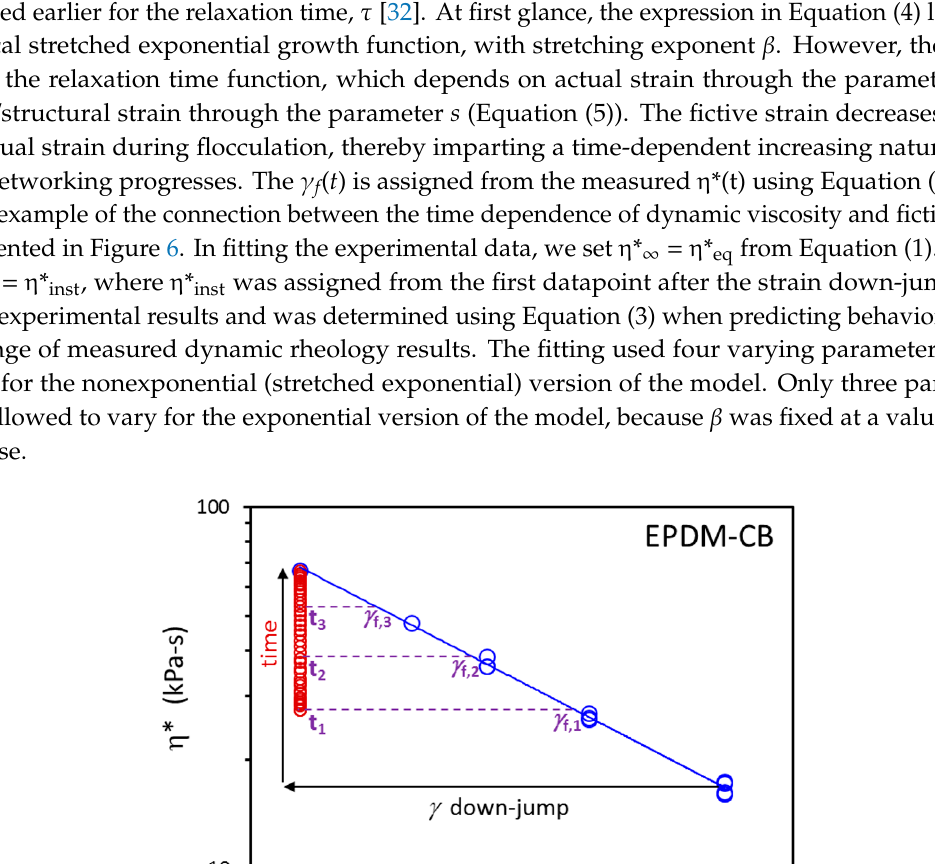
Figure 7. Time-dependent η * data (symbols) after down-jump from equilibrium at γ = 0.25 to the indicated γ values and fictive strain model fits (solid lines) for EPDM-CB using the exponential ( a ) and stretched exponential ( b ) versions of the model.